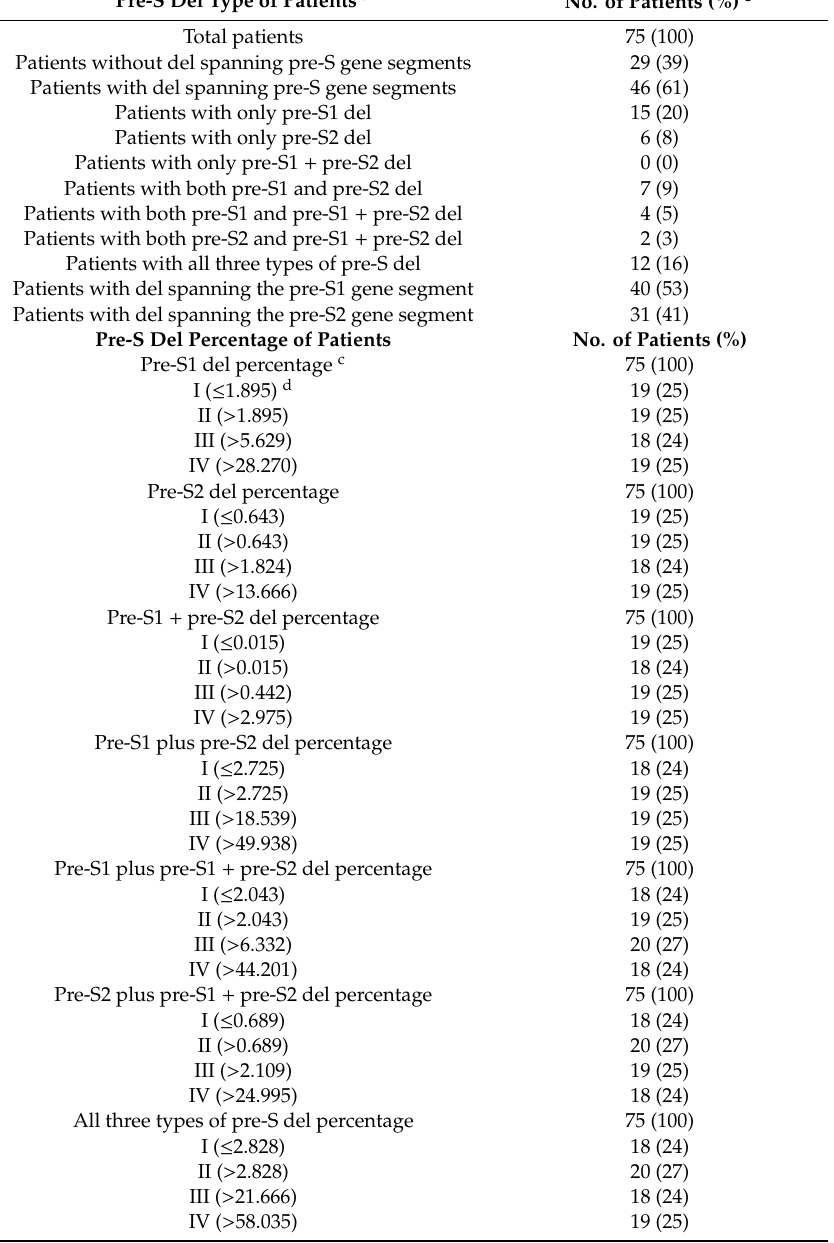
Table 2. Summary of NGS-based pre-S genotyping result in 75 HBV-related HCC